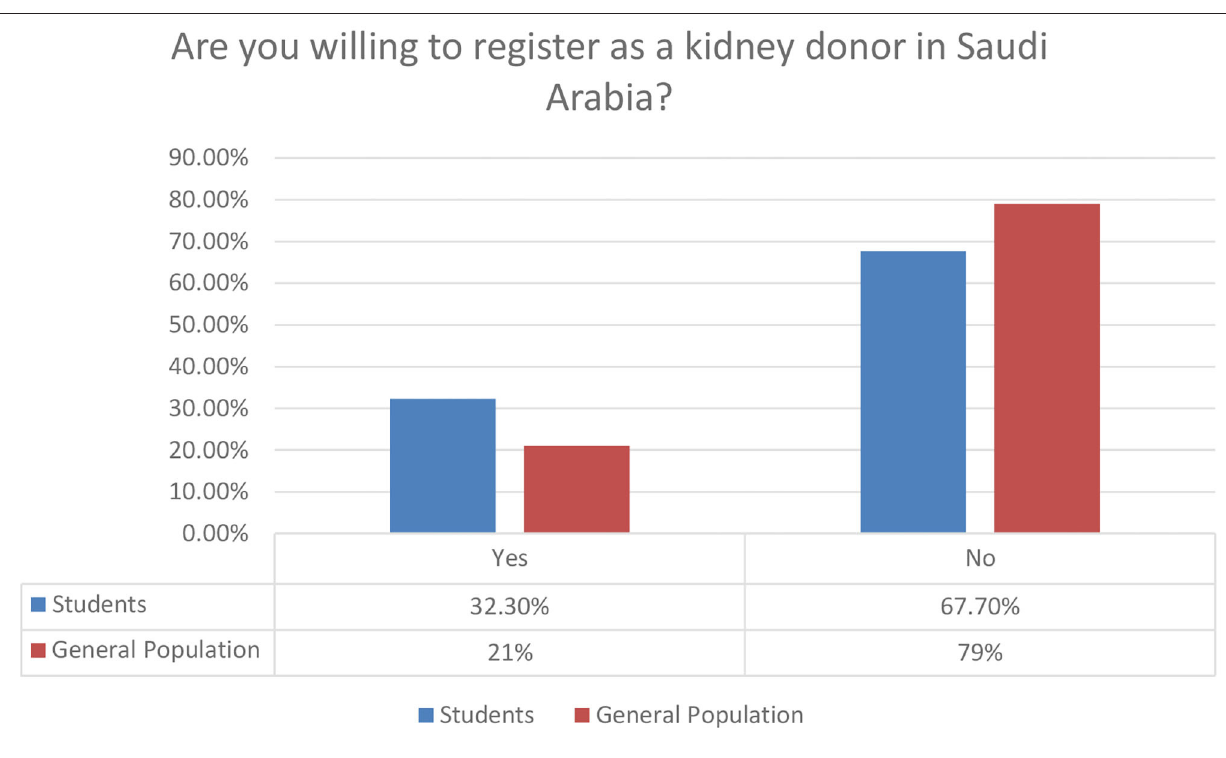
Frontiers in Public Health |